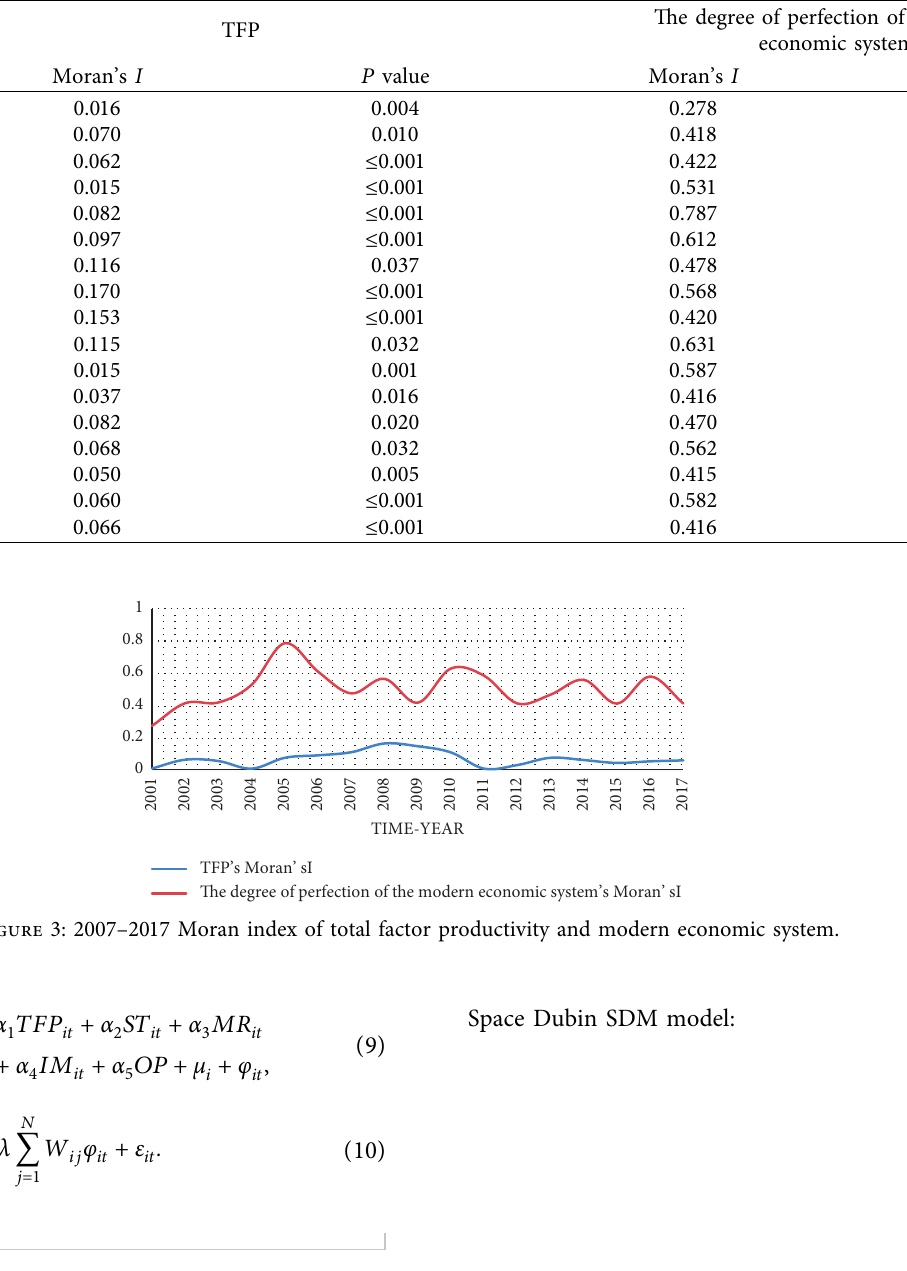
Table 5: 2007–2017 Moran index of total factor productivity and the perfection of the modern economic system.